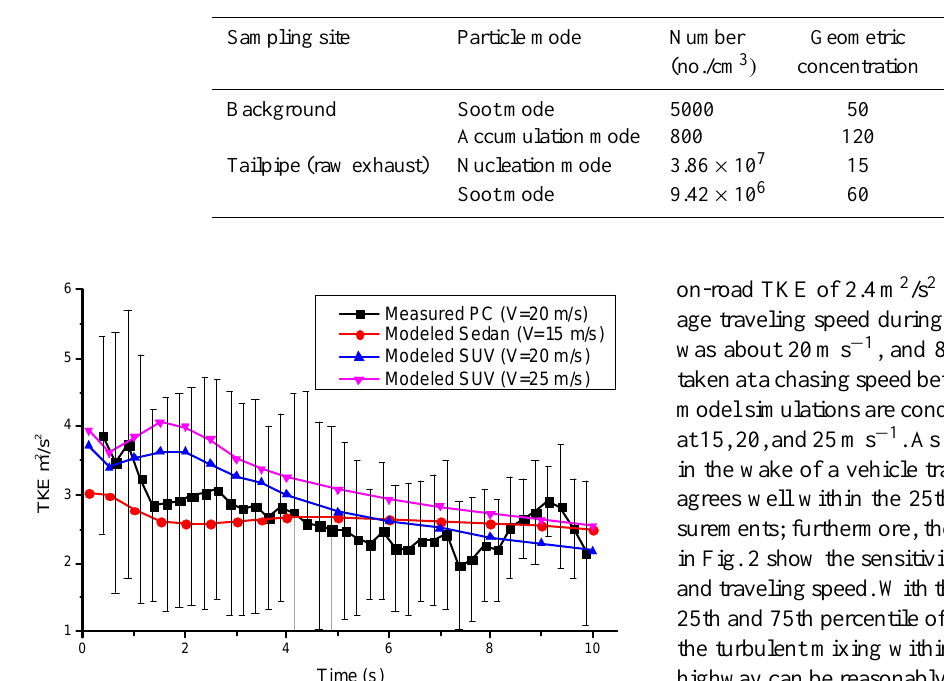
Table 5. Particle number–size distribution parameters assumed by the model.